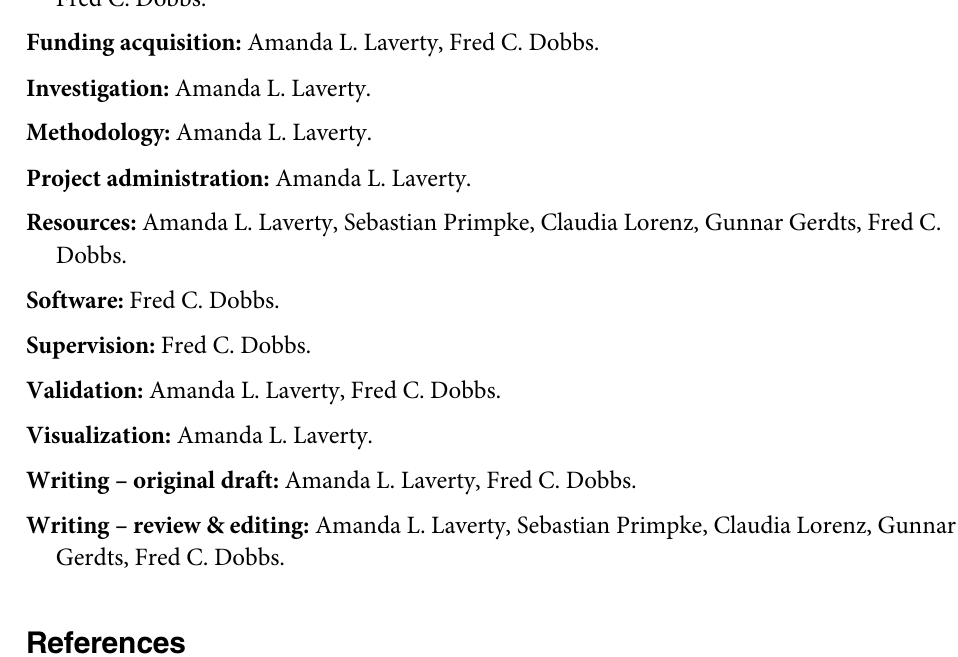
triangles; glass substrate, +; water, filled circles; polypropylene, filled triangles; polycarbonate, x; polystyrene, upside down filled triangles; high-density polyethylene, filled squares; low-den- sity polyethylene, filled diamonds. S3 Fig. Principal components analysis (PCA) of antibiotic profiles identifying the 97 Vib- rio isolates. PC1 and PC2 and symbols as in S2 Fig. Eigenvectors for each antibiotic are shown as lines. Isolates are color coded: magenta, V . vulnificus ; blue, V . parahaemolyticus ; green, V . cholerae